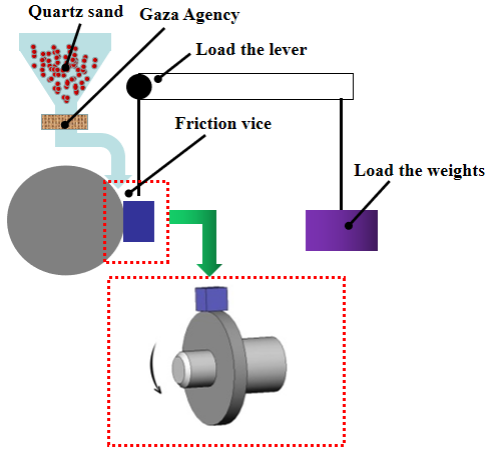
Figure 2. self-made wear tester of abrasive particles. Figure 2. Self-made wear tester of abrasive